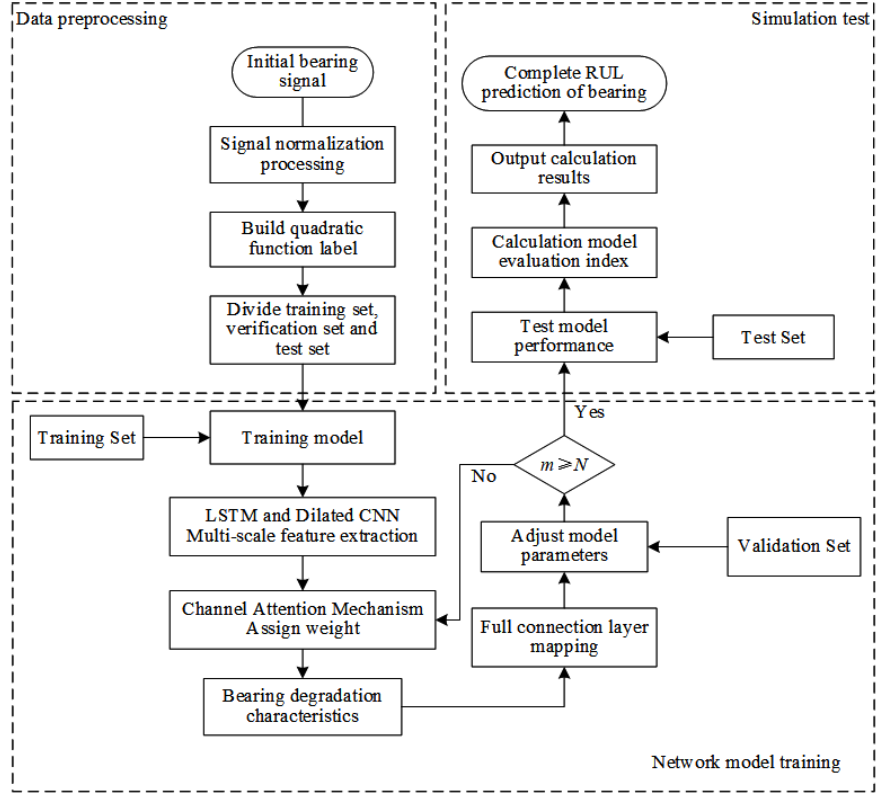
Figure 5. Flow chart of the RUL prediction method in this